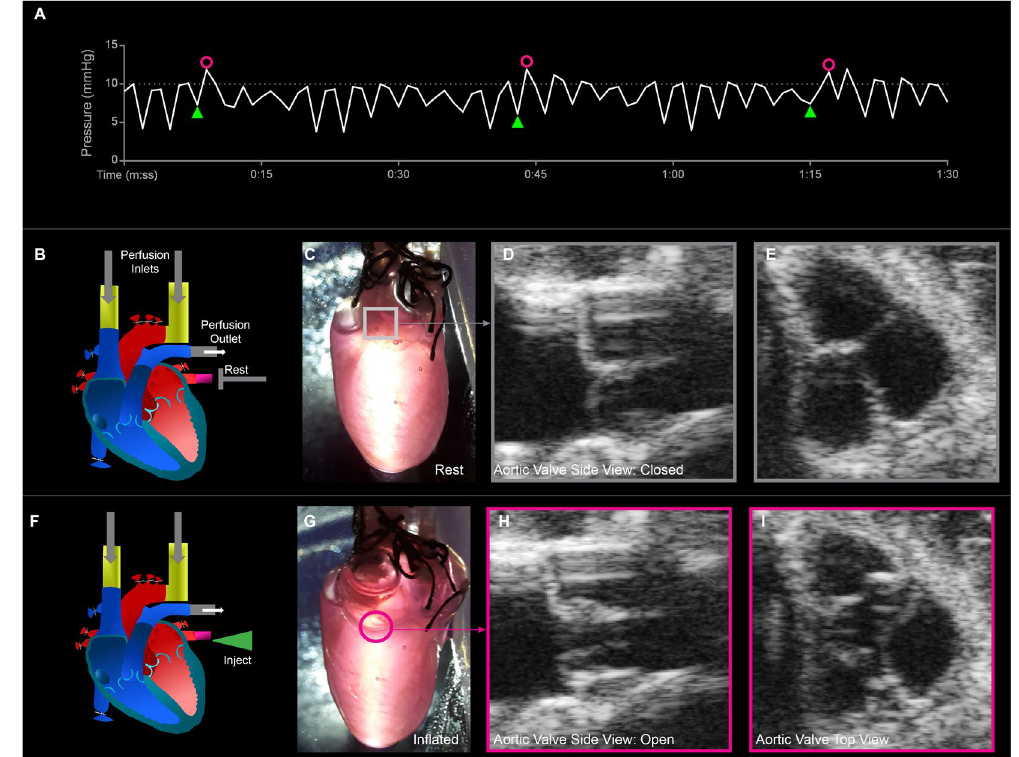
Figure 4. Observations of decellularized 4-Flow heart conformity and aortic valve competence under cyclic mechanical stimulation and constant perfusion (accellular heart). ( A ) By monitoring the fluid pressure fluctuations right before the ascending aorta, characteristic pressure fluxes (pink circles) due to PV injection (green triangles) can be distinguished from the relaxed pressure ranges. During rest with only SV and AA perfusion, the heart is at the relaxed phase with the aortic valve closed maintaining pressure ranging from 5–10 mmHg due to the peristaltic perfusion. During the injection phase initiated by the injection of medium (green triangle) through the PV into the left atrium and then to the left ventricle inflating and increasing pressure within a few seconds before the aortic valve opens (pink circle). Once the aortic valve opens, the medium is dissipated into the coronary arteries resulting in lowered ventricular pressure and closing of the aortic valve returning to the rest phase. ( B , F ) The schematic illustrates the injection route at the PV (rest: gray T, injection: green triangle), perfusion inlets at the AA and SV, flow outlet, and also the state of each valve. With cyclic injection of medium through the PV in addition to continuous perfusion through the SV and AA the heart undergoes a relaxed phase ( C ) and a stretched phase ( G ). ( C , D , H , I ) The cyclic ventricle inflation and deflation, and opening and closing of the aortic valve can be observed through ultrasound